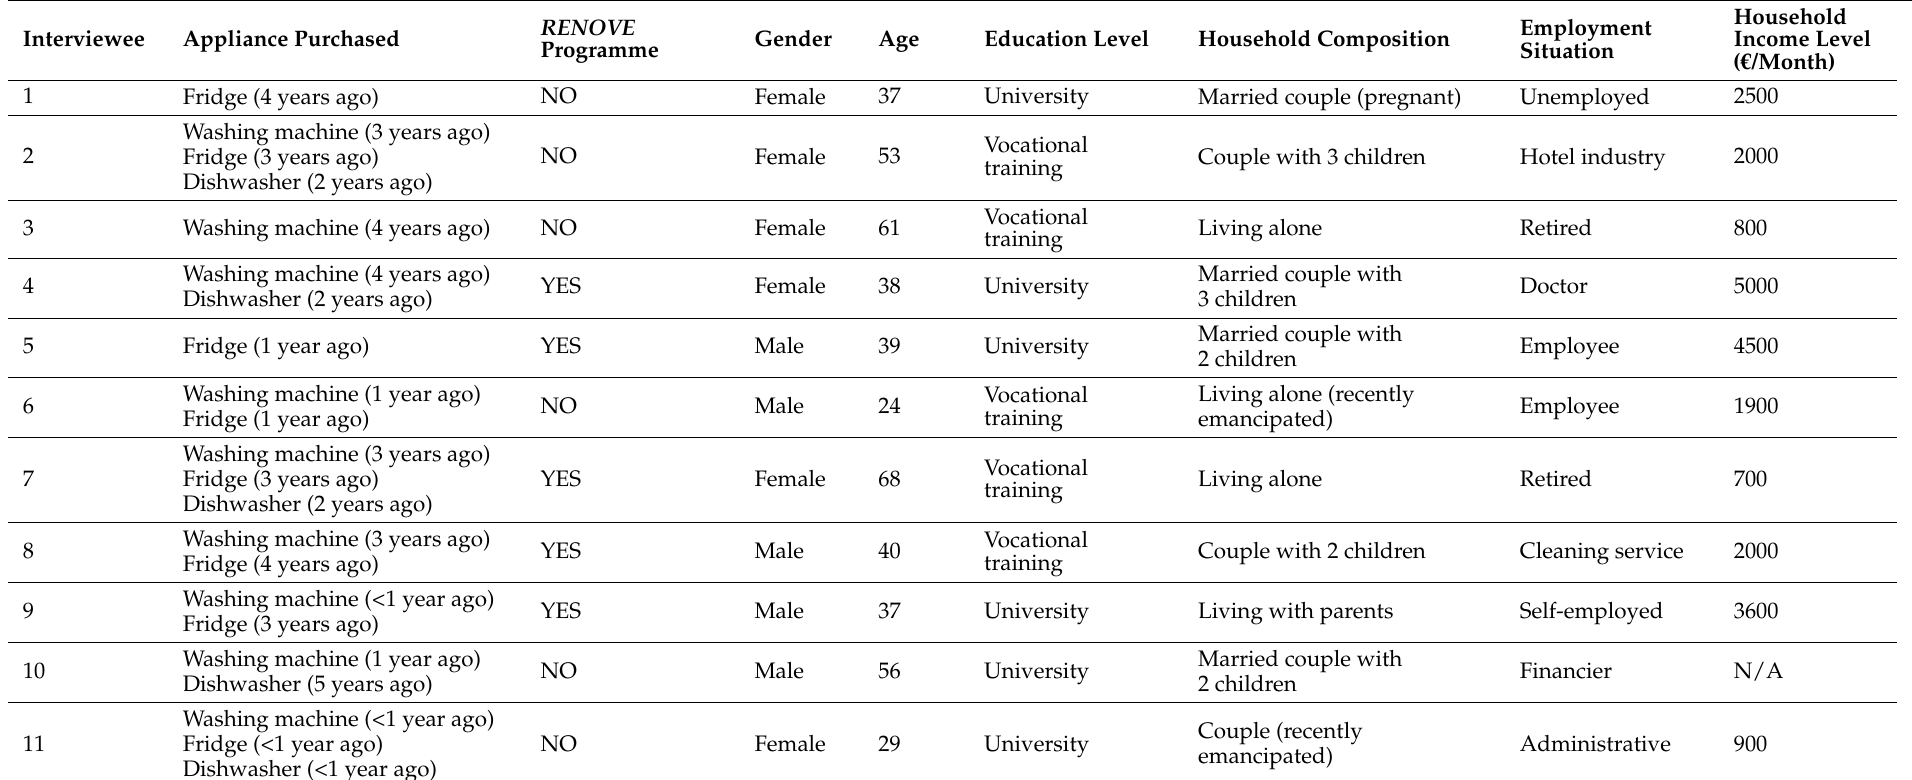
Table A1. Sample of members of the